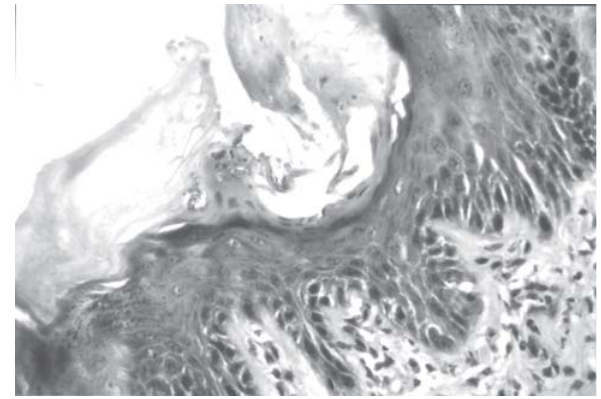
FIGURE 3- Microscopic section of a specimen in Group III exhibiting focal area of hyperparakeratinization associated to microbial biofilms in an apparently traumatized region, with some disorganization of epithelial stratification and focal mononuclear inflammatory infiltrate immediately below the connective tissue